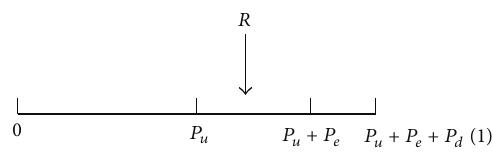
Figure 1: The two-state Markov model.